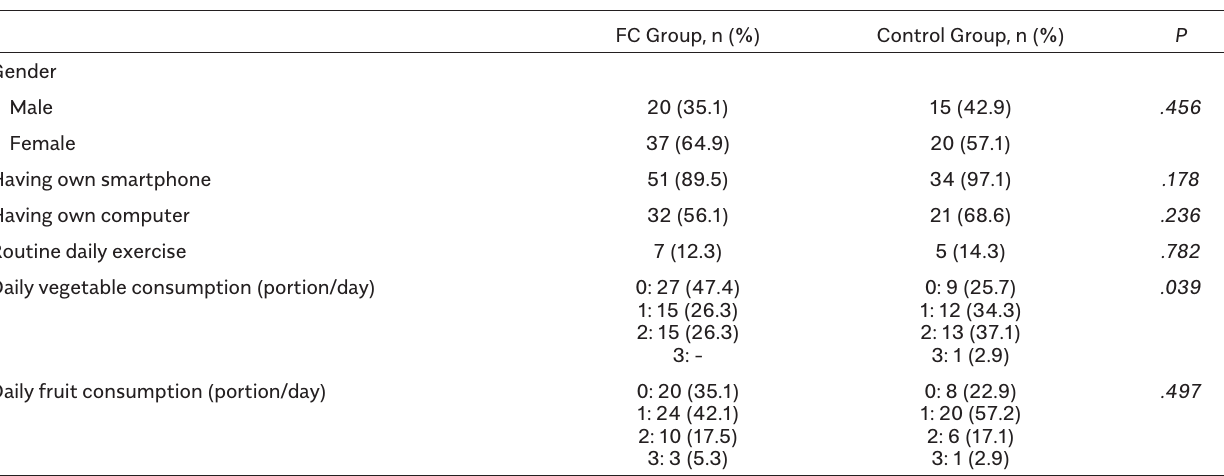
Table 1. Sociodemographic Features of the Study Population